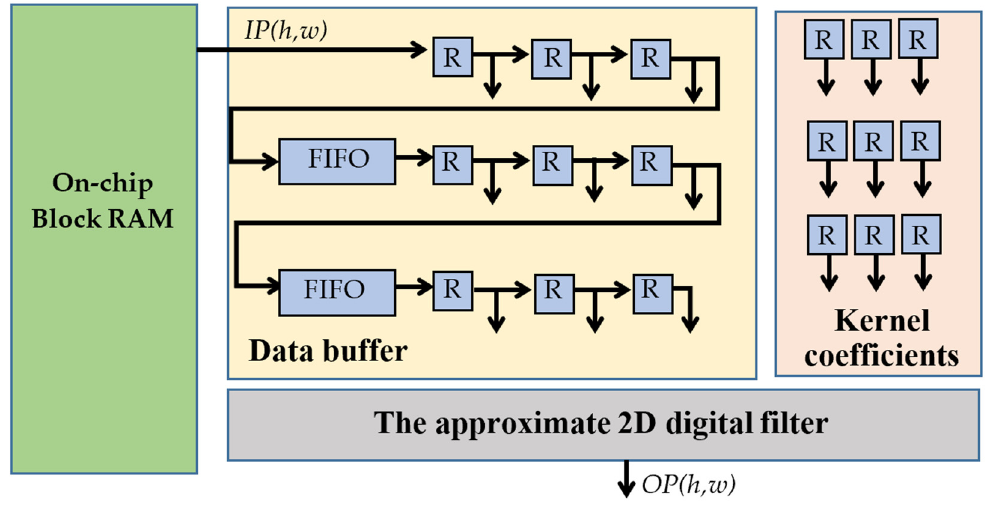
Figure 12. The examined real application.